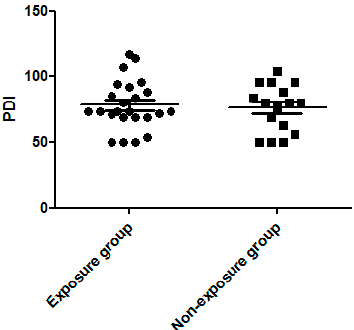
Figure 2. No significant difference in the Psychomotor Developmental Index (PDI) between the dexamethasone exposure and non-exposure groups.